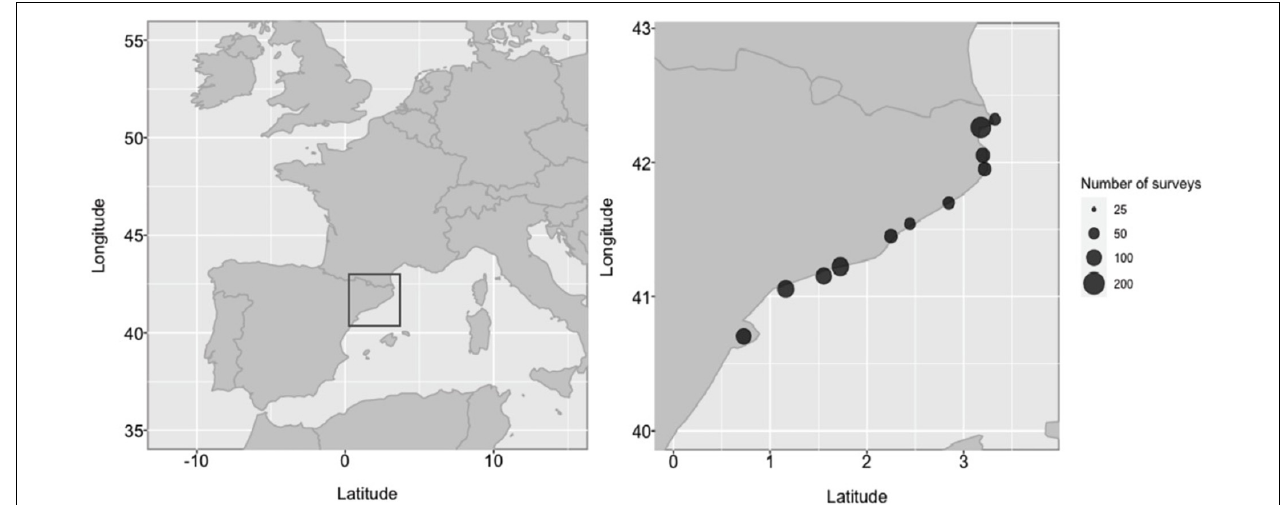
FIGURE 1 | Area of study (Catalonia, NW Spain; left) and sample size obtained from each of the 11 surveyed zones